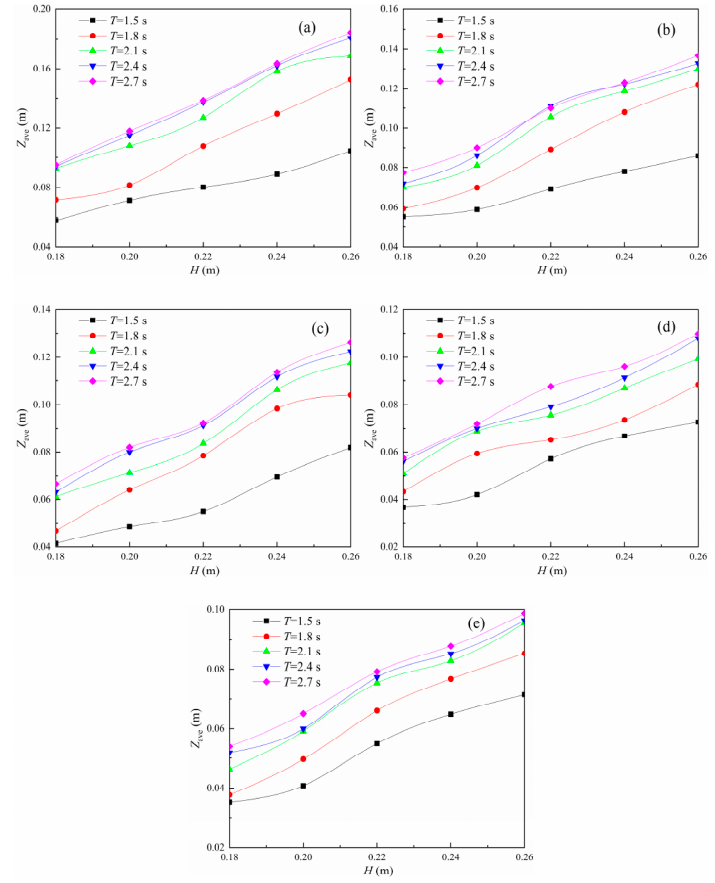
Figure 3. Z ave relationship with H. ( a ) h = 0.1 m; ( b ) h = 0.2 m; ( c ) h = 0.3 m; ( d ) h = 0.4 m; ( e ) h = 0.5 m.